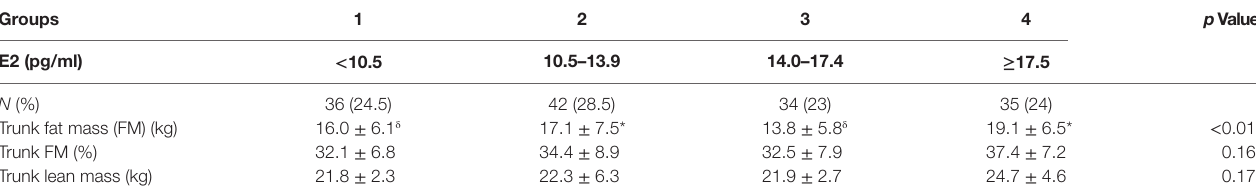
TaBle 2 | Body composition of the trunk according to estradiol (E2) categories. groups